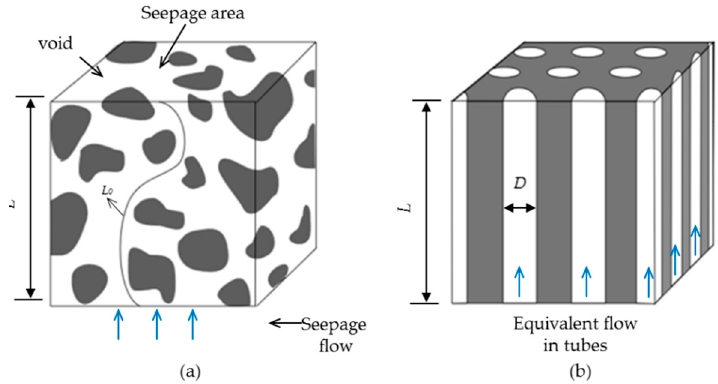
Figure 2. ( a ) Seepage field and ( b ) its equivalent tubes within a unit volume.